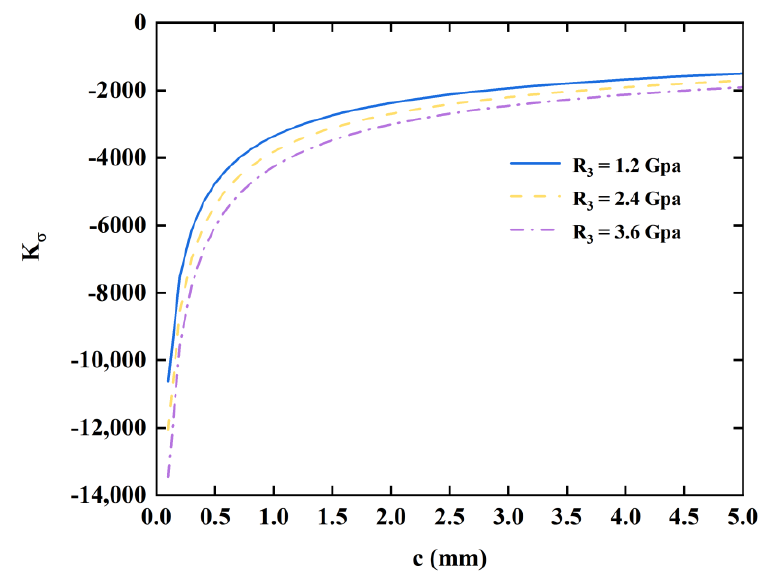
Figure 4. Influence of coupling elastic coefficient R 3 on the phonon filed stress intensity